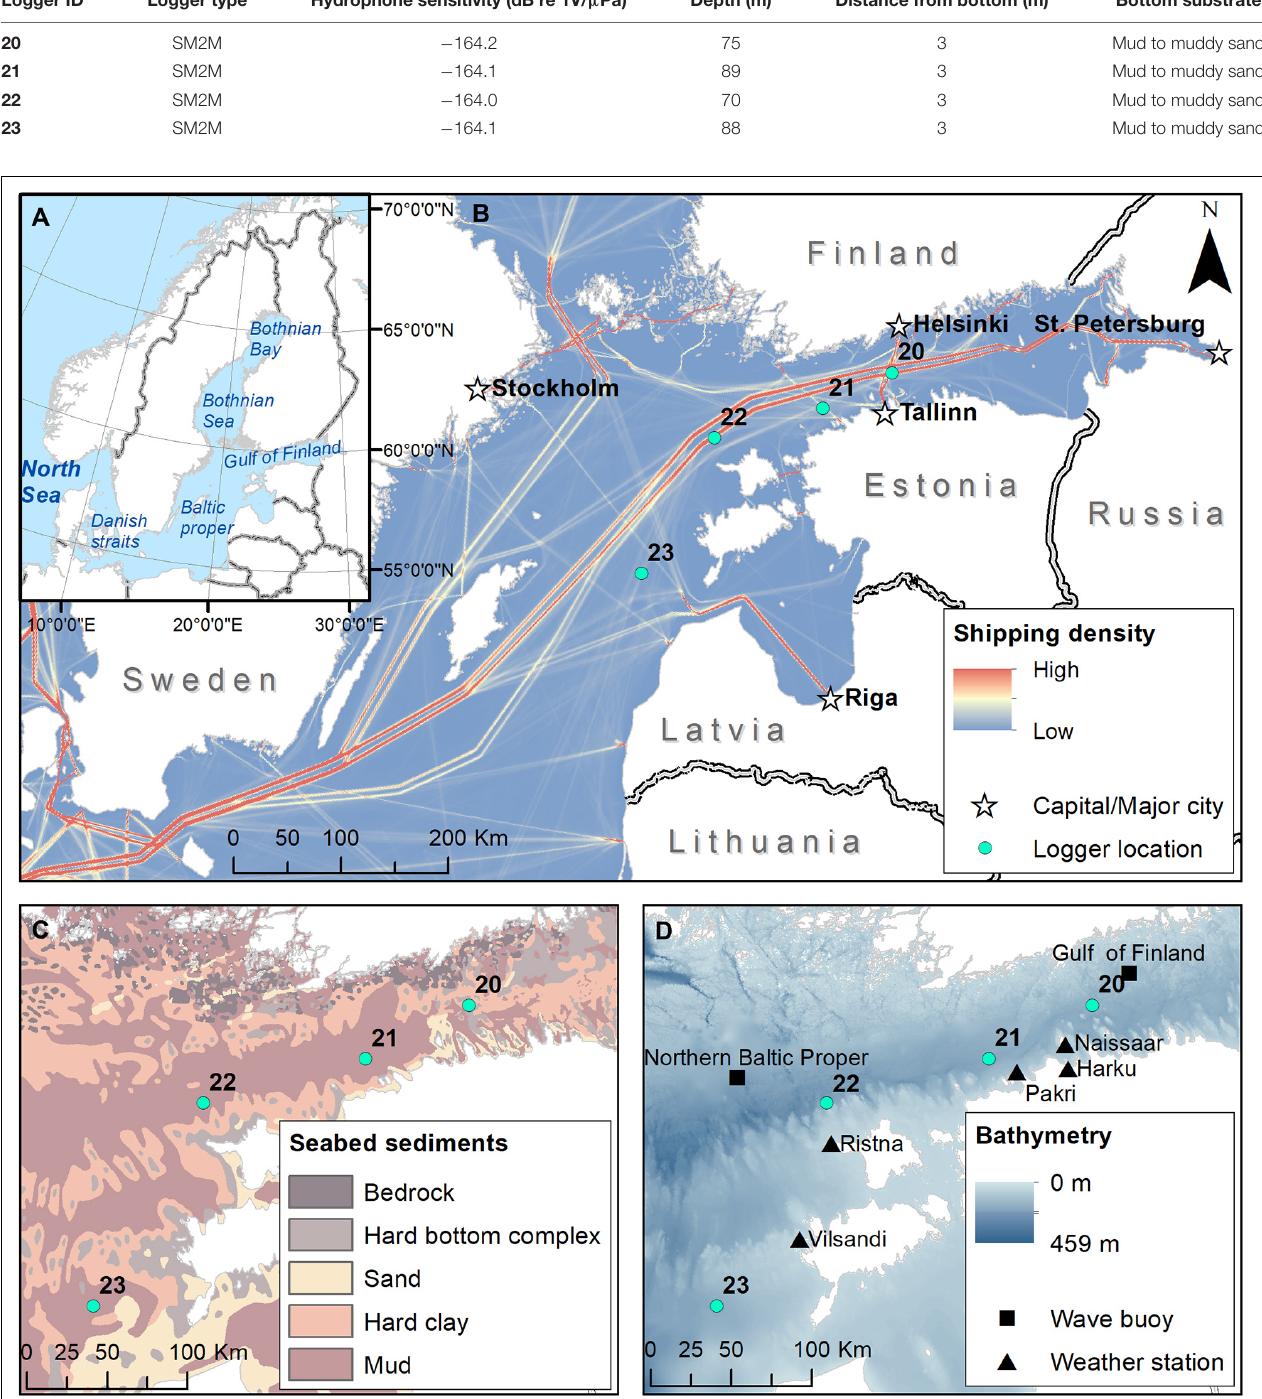
FIGURE 1 | Geographical characteristics of the study area. (A) Location in the Baltic Sea region. (B) Major shipping routes based on AIS data. (C) Seabed substrate. (D) Sea depth and locations of the acoustic data loggers. Individual logger depths are 60, 90, 80, and 80 m for loggers 20, 21, 22, and 23, respectively. In (B–D) , cyan dots with numbers from 20 to 23 show the locations of the hydrophone loggers used in this study. Data sources: HELCOM AIS database (2017); BALANCE project, EU BSR Interreg III B (2008); Baltic Sea Bathymetry Database, BSBD (2013); OpenStreetMap. Downloaded from HELCOM map and data service: